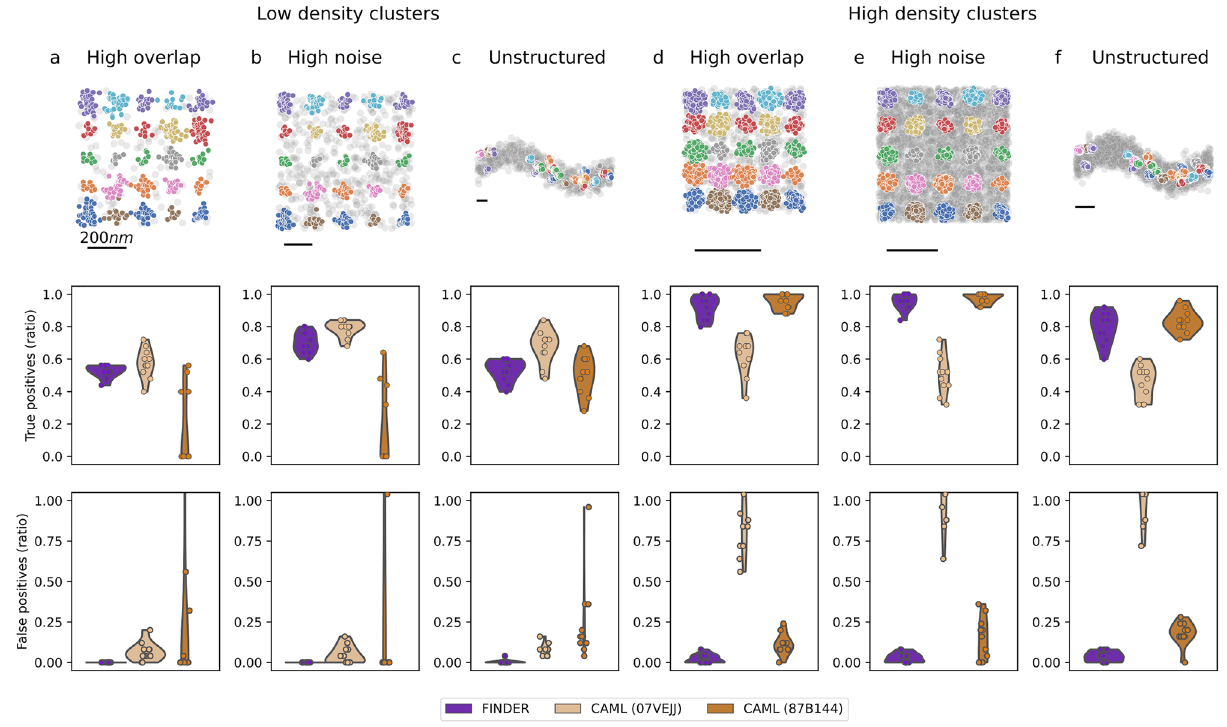
Figure 4. Performance of FINDER and CAML clustering algorithms across synthetic datasets which are composed of clusters of localizations from two libraries. Low-density clusters ( a – c ) are composed of clusters from a SMLM dataset of a a synapse 9 with an average of 17 localizations per cluster. High-density clusters ( e – f ) are composed of manually identified sub-clusters of DNA-origami trimers with on average 113 localizations per cluster. ( a , d ) High overlap: A grid of 5 × 5 clusters with distances equal to the maximal cluster diameter in the dataset, and with 20% random noise localizations (as a fraction of clustered localizations). ( c , d ) High noise: A grid of 5 × 5 clusters with distances equal to the 1.5 times the maximal cluster diameter in the dataset, is superimposed with an equal number ( 100% ) of random noise localizations. ( e , f ) Unstructured: 25 clusters are randomly distributed along a sinusoidal path, with 100% and 150% added random noise localizations (as a fraction of clustered localizations) in c and f, respectively. The top row shows one instance of a randomized pattern for each case, with highlighted ground truth clusters. For further detail, see supplemental figures: S6-S11, and Fig.